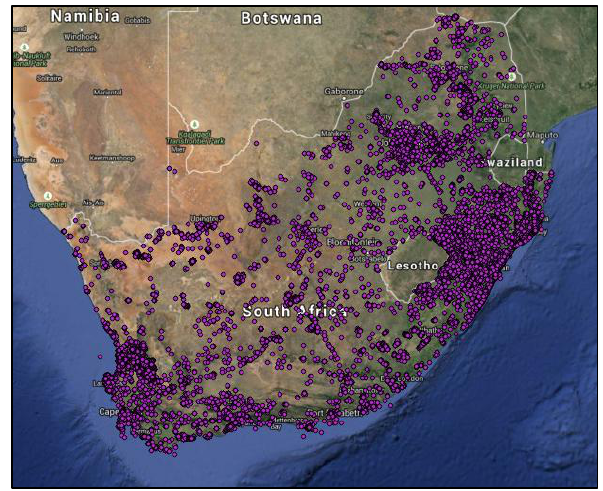
Figure 2: Non-specific site location map